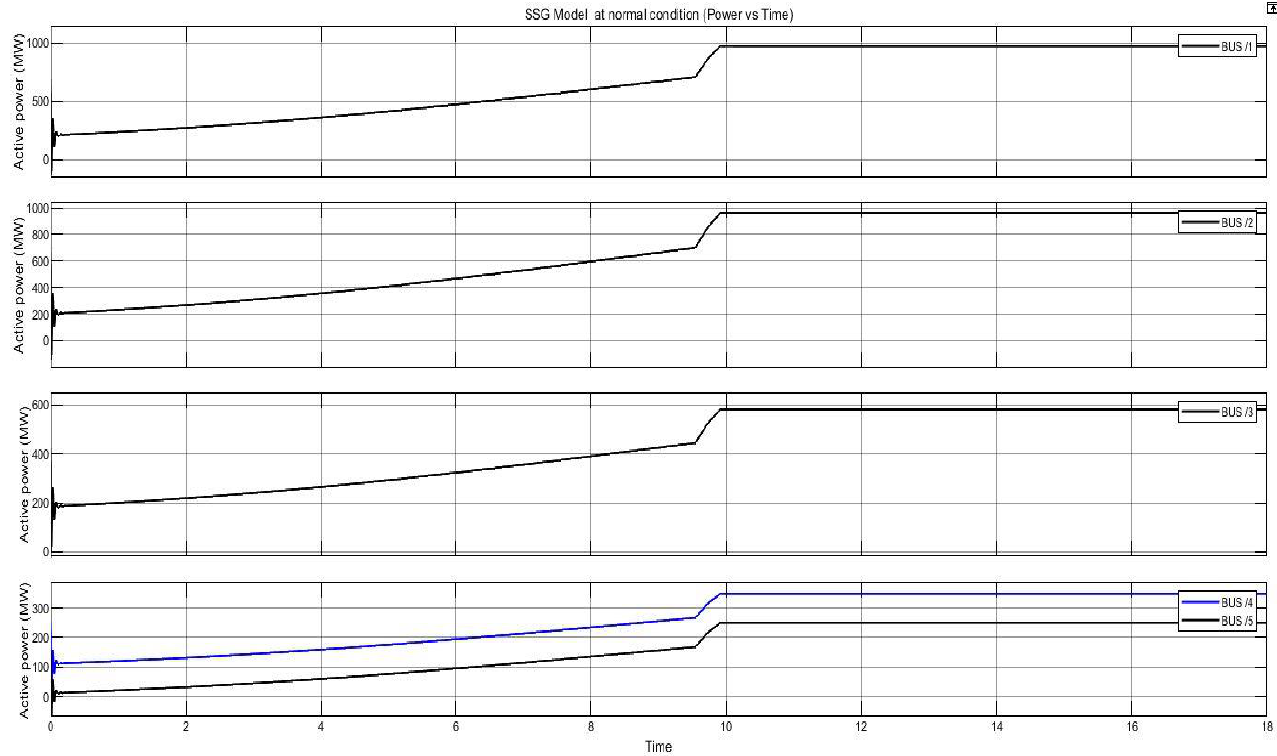
Figure 16. System in normal state, and no fault is introduced (Bus 1 to Bus 5).